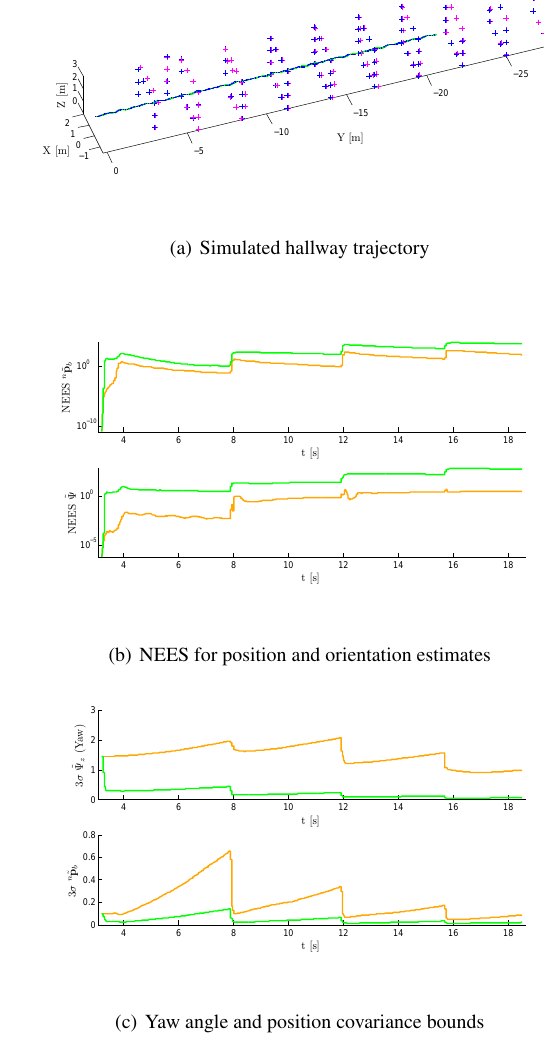
Figure 4: Hallway sequence. Results for one simulation run are shown in Fig. 4(a). Blue: Reference trajectory and reference landmark positions, Pink: Estimated landmark positions, Green: Estimated trajectory. Fig. 4(b) shows the NEES averaged over 25 Monte-Carlo simulation runs. Orange: With cross-covariance estimation for new landmarks. Green: without cross-covariance estimation. Notice the log scale in the NEES-plots. Fig. 4(c) compares the estimated covariance bounds for yaw angle and po- sition estimates. Orange: With cross-covariance estimation for new landmarks. Green: without cross-covariance